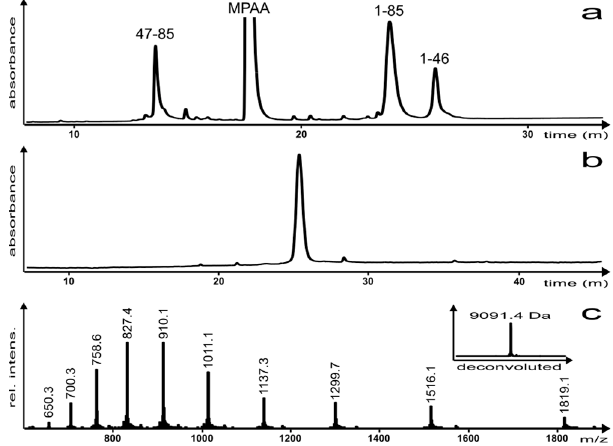
Figure 3. ( a ) NCL reaction after 4 h; ( b ) analytical RP-HPLC of the purified EqtII(1–85) analogue and ( c ) ESI-MS of the purified EqtII(1–85) analogue (inset: Deconvoluted spectrum; molecular mass (calc.) = 9091.4 Da). Please note that chromatograms ( a , b ) were analyzed using different HPLC